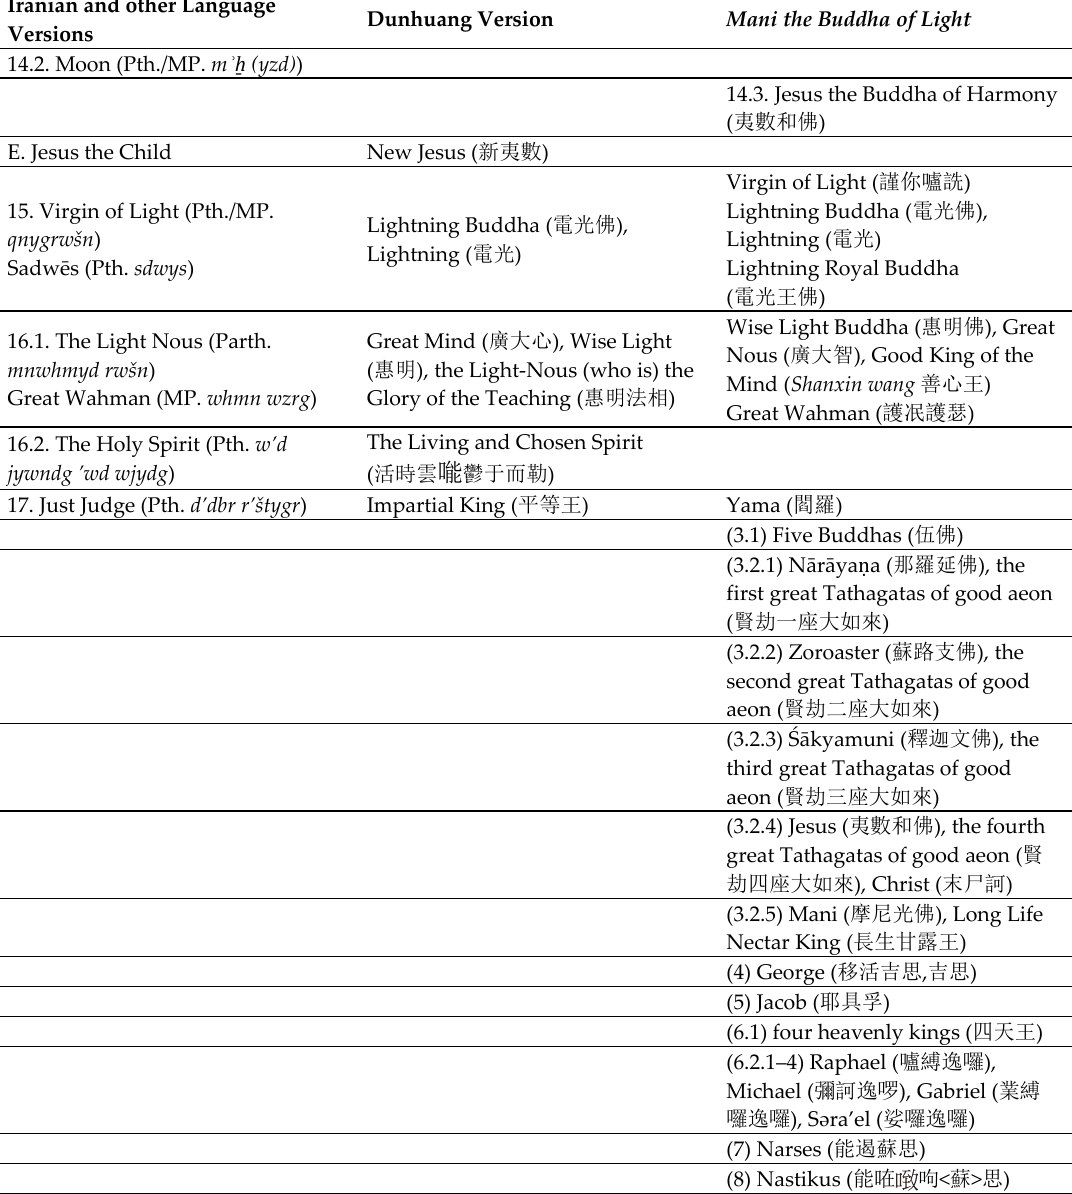
Table 1. Cont. Religions 2017 , 8 , x FOR PEER REVIEW 33 of